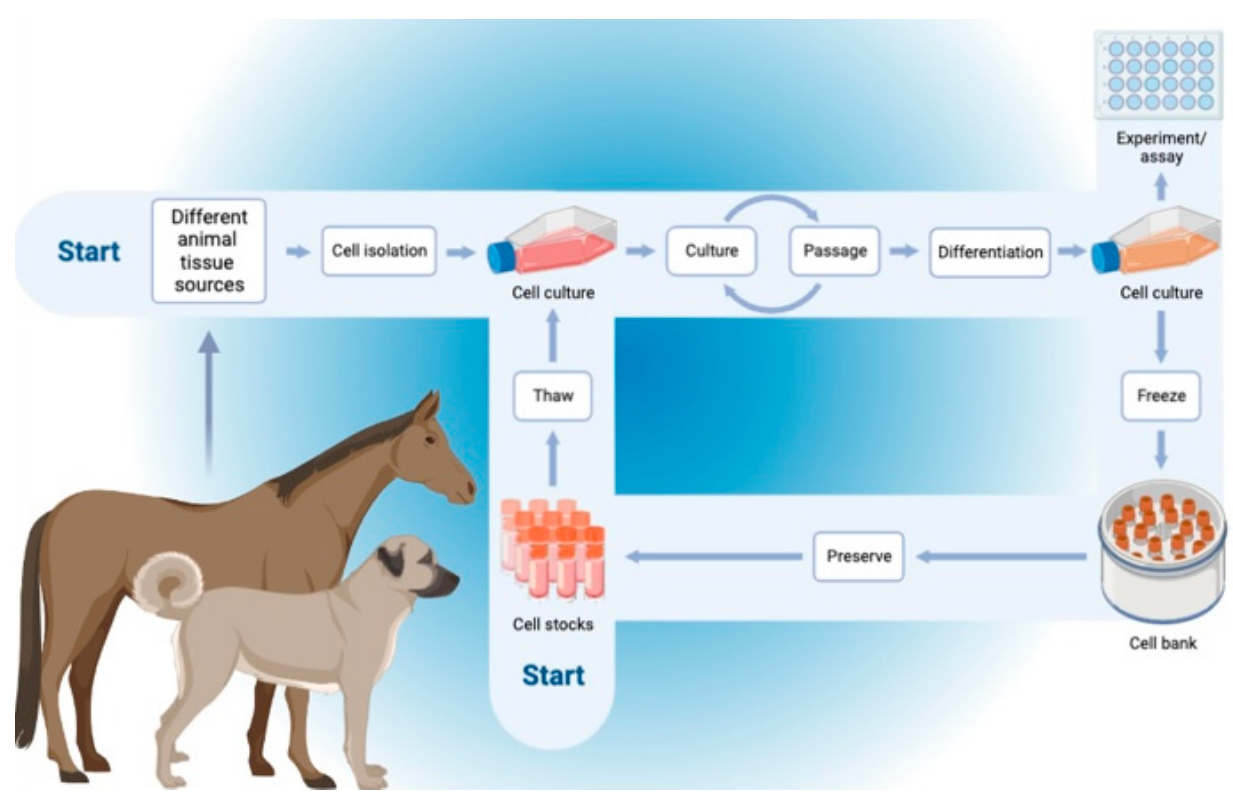
Figure 3. Schematic representation of the workflow of the autogenic and allogenic mesenchymal stem cells from the harvesting, culturing, storage, and use.